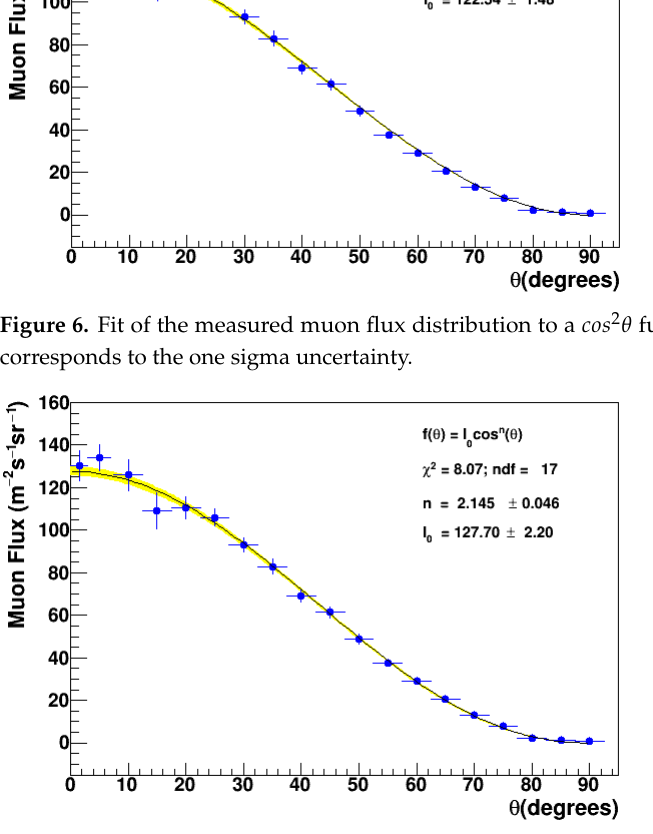
Figure 7. Fit of the measured muon flux distribution to a cos n θ function. The yellow band shown corresponds to the one sigma